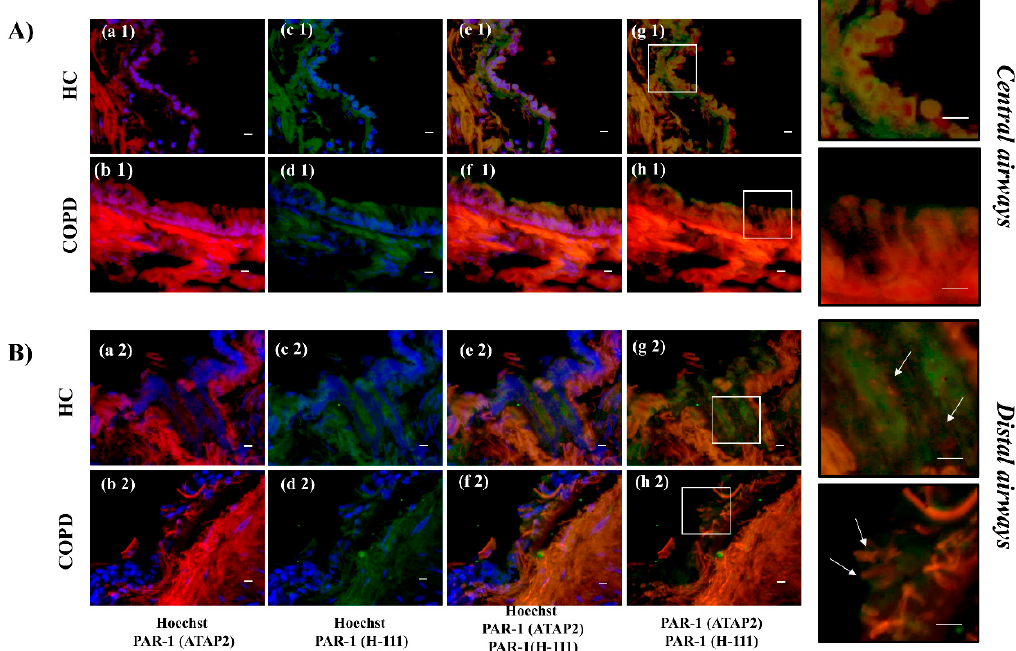
Figure 2. Immunofluorescent reactivity of anti-PAR-1 ATAP-2 A and anti-PAR-1 H-111 Abs in epithelial cells from surgical specimens from the central and distal airway of HC and COPD subjects. ( A ) Epithelial cells from the central airways showed single staining for anti-PAR-1 ATAP-2 Ab ( red ) ( a1 , b1 ) or anti-PAR-1 H-111 Ab ( green ) ( c1 , d1 ), or a double staining for anti-ATAP-2/H-111Abs with ( e1 , f1 ) or without nuclear staining Hoechst ( blue ) ( g1 , h1 ). ( B ) Epithelial cells from distal airways showed the single staining for anti- PAR-1 ATAP-2 Ab ( red ) ( a1 , b1 ) or anti- PAR-1 H-111 Ab ( green ) ( c1 , d1 ), or a double staining for anti- ATAP-2/H-111 with ( e2 , f2 ) or without nuclear staining with Hoechst ( blue ) ( g1 , h1 ). The scale bar is 50 µm. Representative staining for each marker was shown. The magnification area shows the co-localization/distribution of anti-PAR-1 ATAP-2 Ab and anti- PAR-1 H-111 Ab immunofluorescent staining.